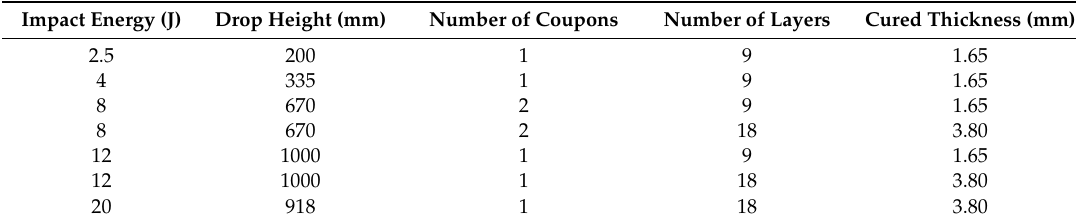
Table 2. Aircraft-grade specimen characteristics.